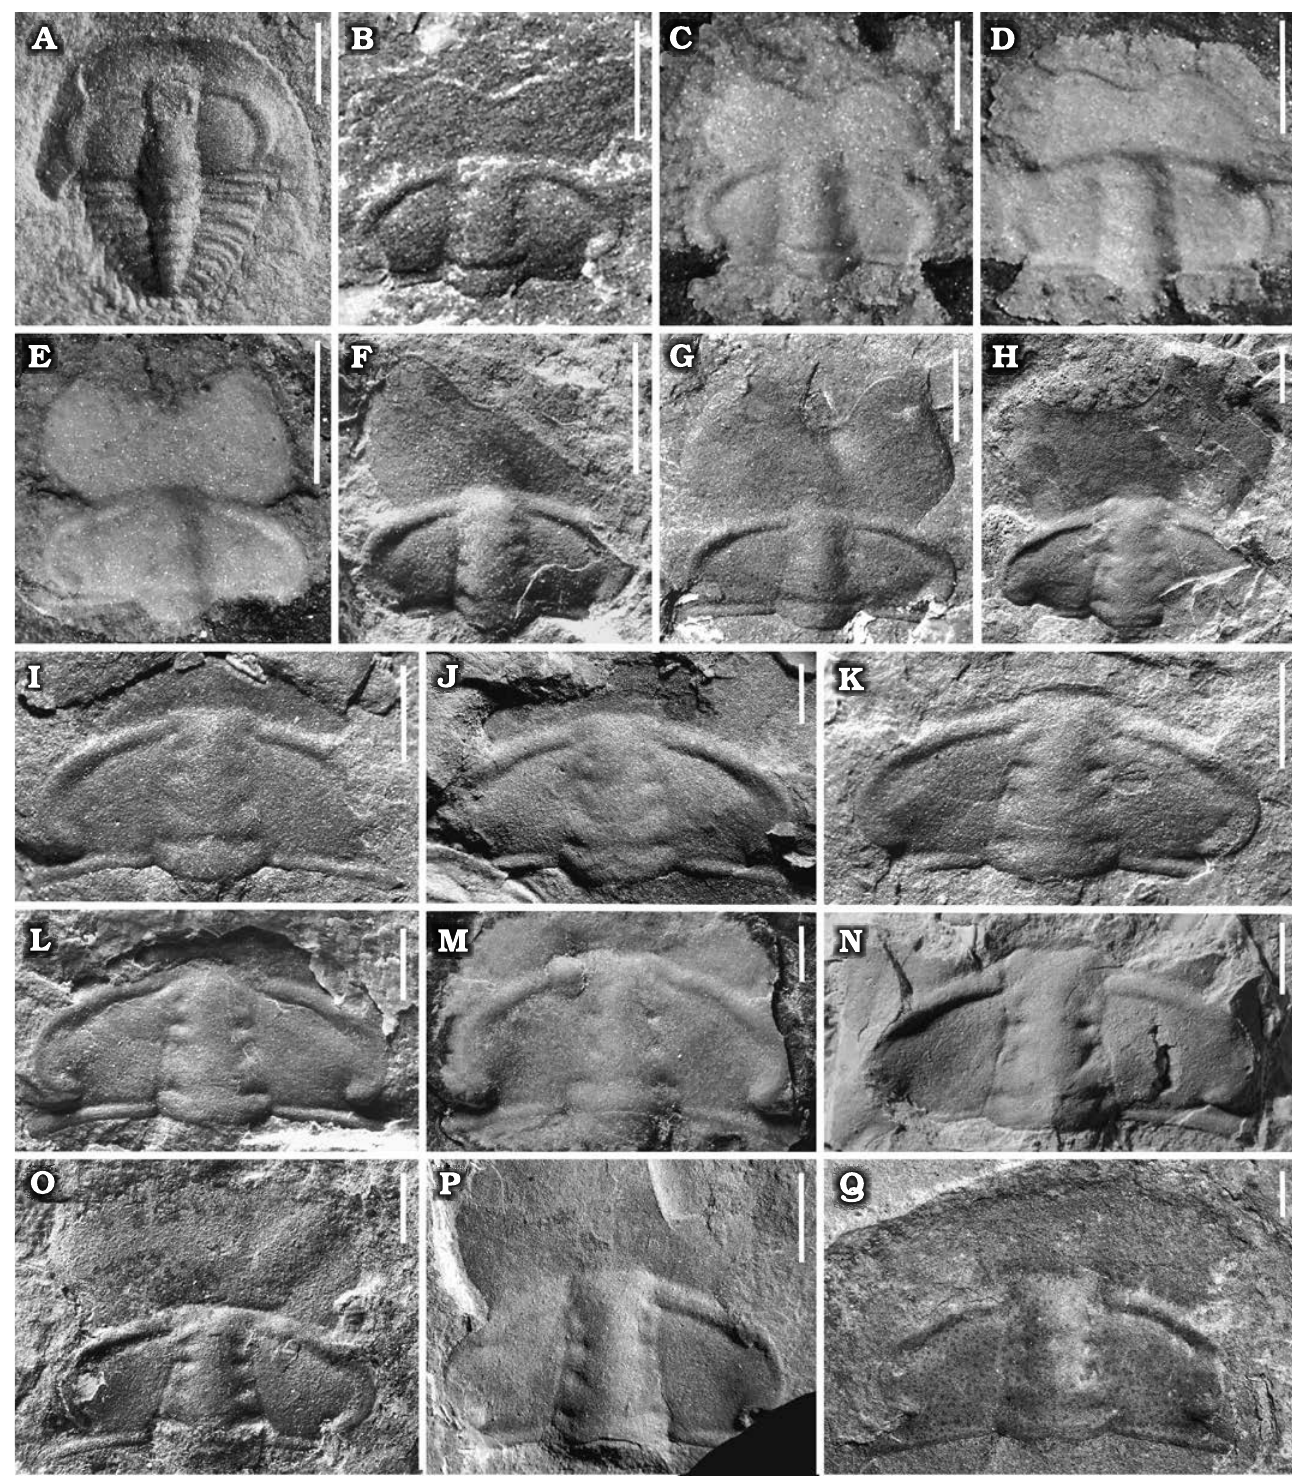
Fig. 4. Ontogenetic series of a ptychoparioid trilobite Phantaspis auritus gen. et sp. nov. from the middle Cambrian (Miaolingian, Wuliuan) Mantou Formation, Longgang section, Shandong Province, North China. A . NIGPAS 172113, complete exoskeleton in meraspid degree 4. B – F . Complete meraspid stage cranidia. B – E . NIGPAS 172114a–d, respectively. F . NIGPAS 172116. G – Q . Holaspid cranidia. G . NIGPAS 172115. H – K .